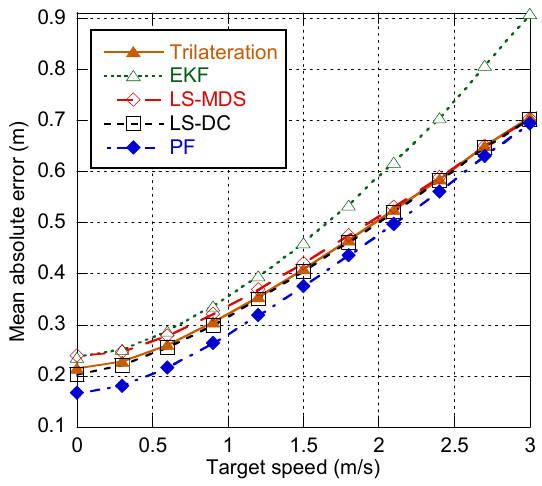
Figure 9. Positioning error depending on target